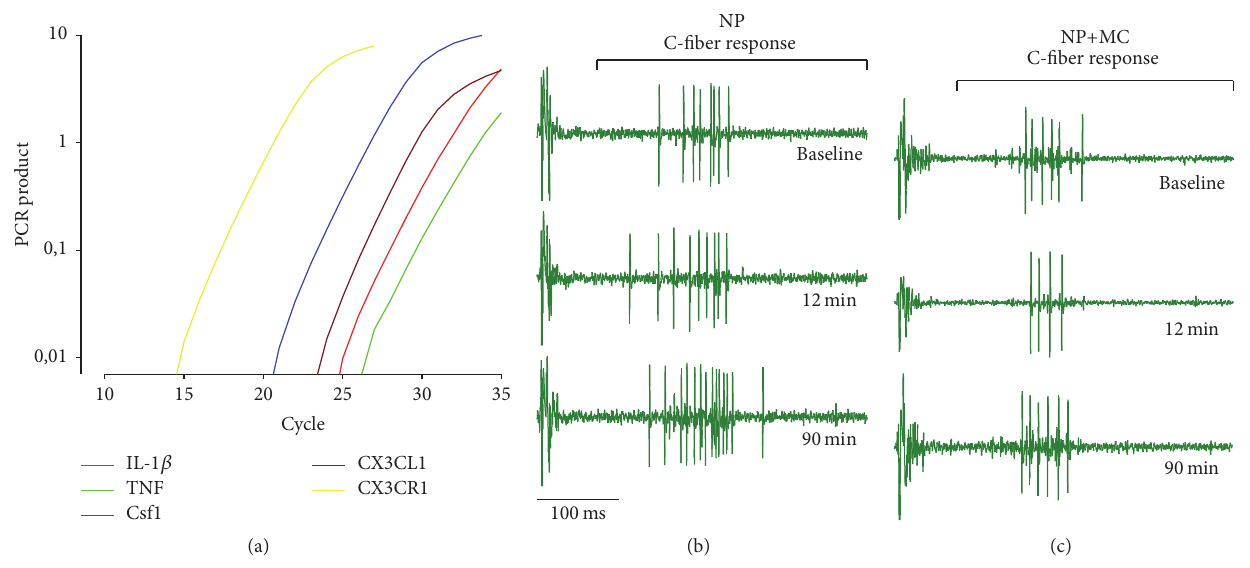
Figure 1: (a) Examples of qPCR amplification plots demonstrating the presence IL-1 𝛽 (red), TNF (green), Csf1 (blue), CX3CL1 (brown), and CX3CR1 (yellow) in native NP tissue. (b) Examples of single cell recordings at baseline, 12 minutes and 90 minutes after nucleus pulposus conditioning alone. (c) Examples of single cell recordings at baseline, 12 minutes and 90 minutes after nucleus pulposus conditioning together with